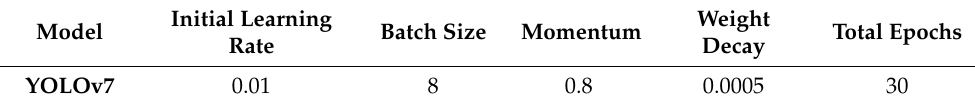
Table 2. Values of all hyper-parameters for